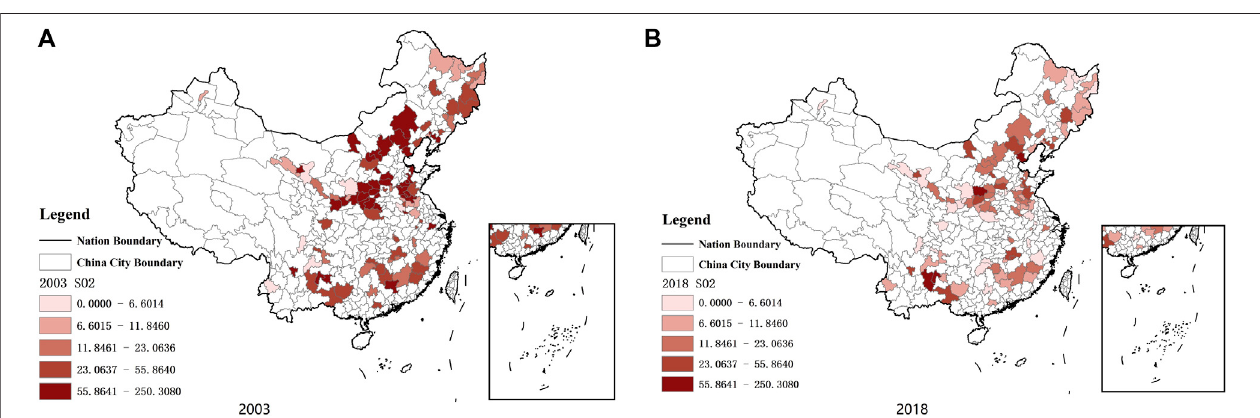
FIGURE 2 | Emission concentration of SO 2 in resources-dependent cities in 2003 (A) and 2018 (B) .